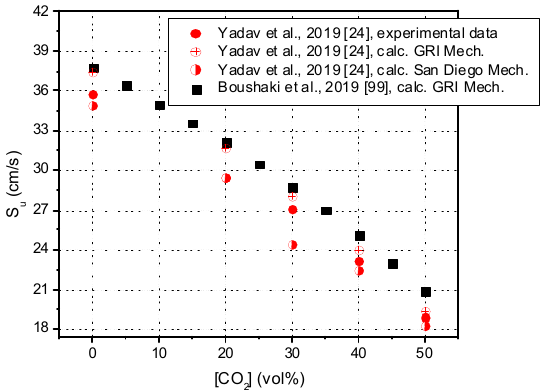
Figure 6. Variation of experimental and calculated laminar burning velocities with carbon dioxide content for mixtures with stoichiometric equivalence ratio, at standard initial conditions.